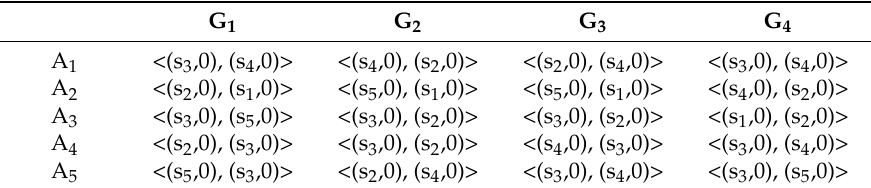
Table 3. 2TLPFN decision matrix ( R 3 ) .